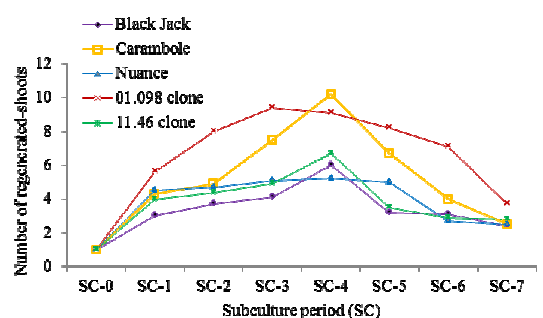
Fig. 4. Number of regenerated-shoots derived from different responses of Gerbera varieties-clones under periodical subculture every 1.5 months